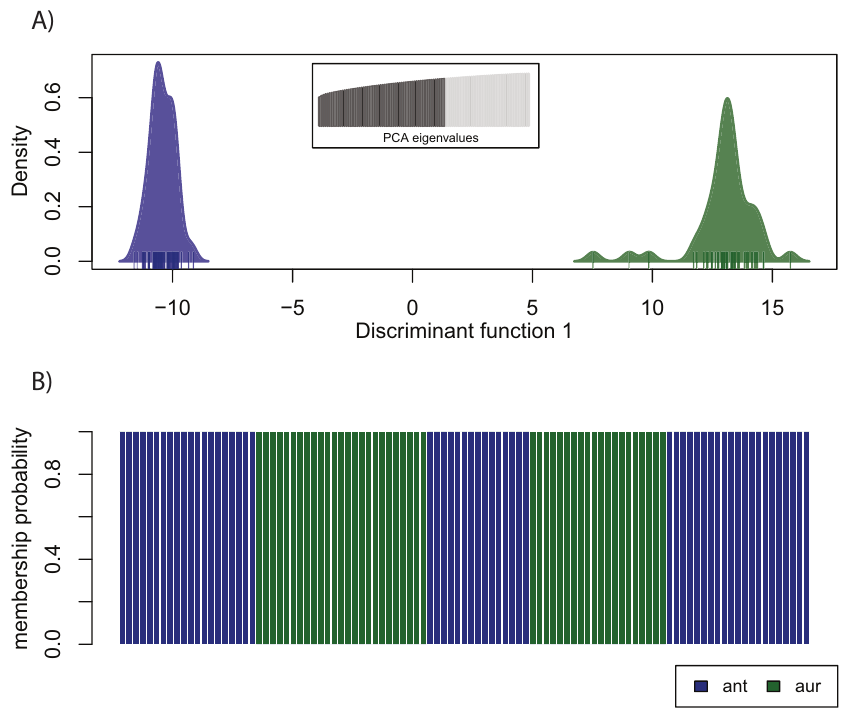
Figure 3. Genomic variation by non-parametric DAPC. A DAPC plot of the densities of U. antarctica (blue) and U. aurantiacoatra (green) on the first retained discriminant function B Bar plot of group mem- bership